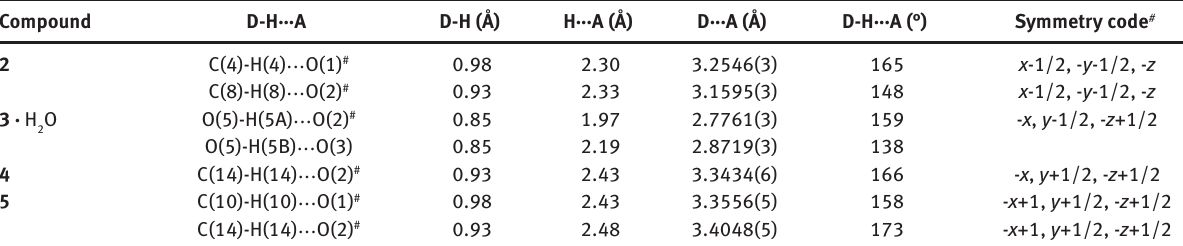
Table 2: H-Bonding geometry parameters (Å, ° ) for the complexes.